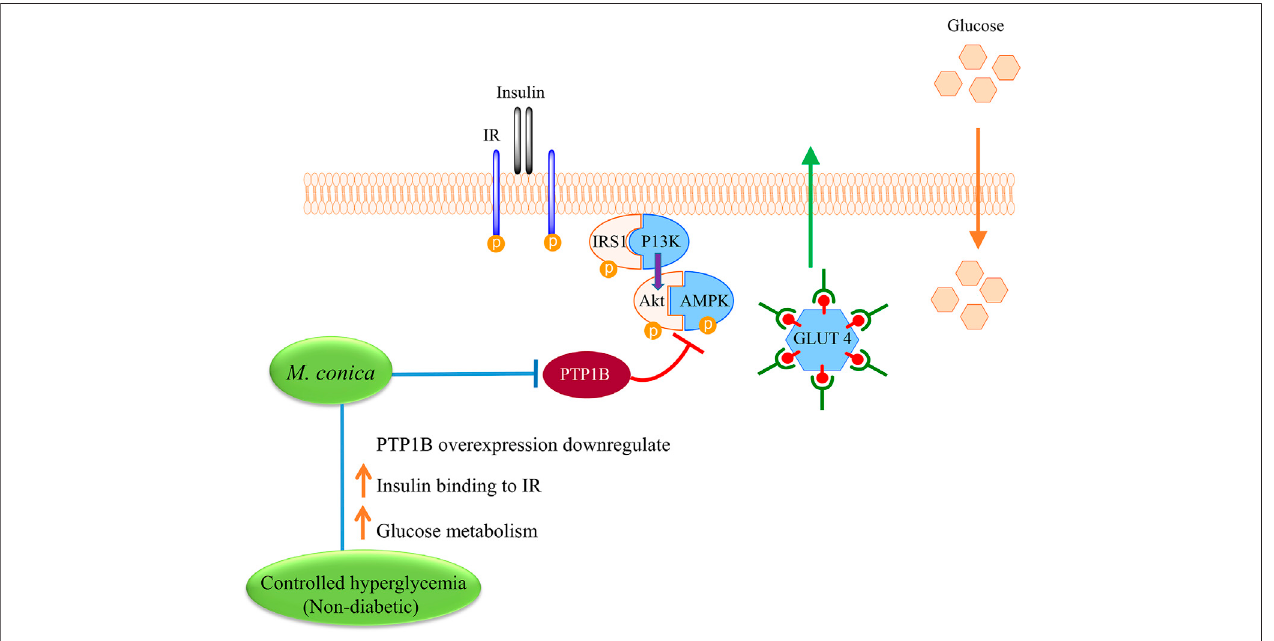
FIGURE6| Proposedmechanismforexploringpossibleeffectof M.conica onimprovinginsulinbindingtoinsulinreceptor(IR)andincreaseglucosemetabolism. M.conica ,decrease the PTP1B expression and increase the phosphorylation of PTP1B targets in the insulin signaling pathways. This leads to increase the insulin sensitivity and reduce the blood glucose.